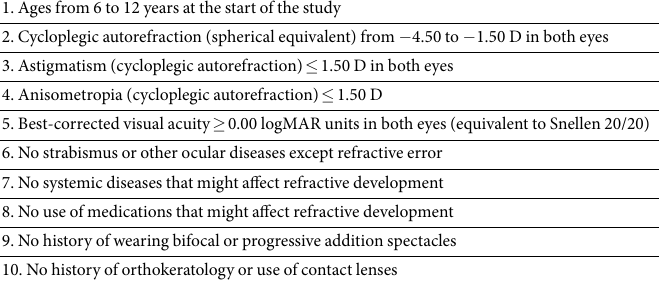
Table 5. Eligibility Criteria. D = dioptre, logMAR = logarithm of the minimum angle of